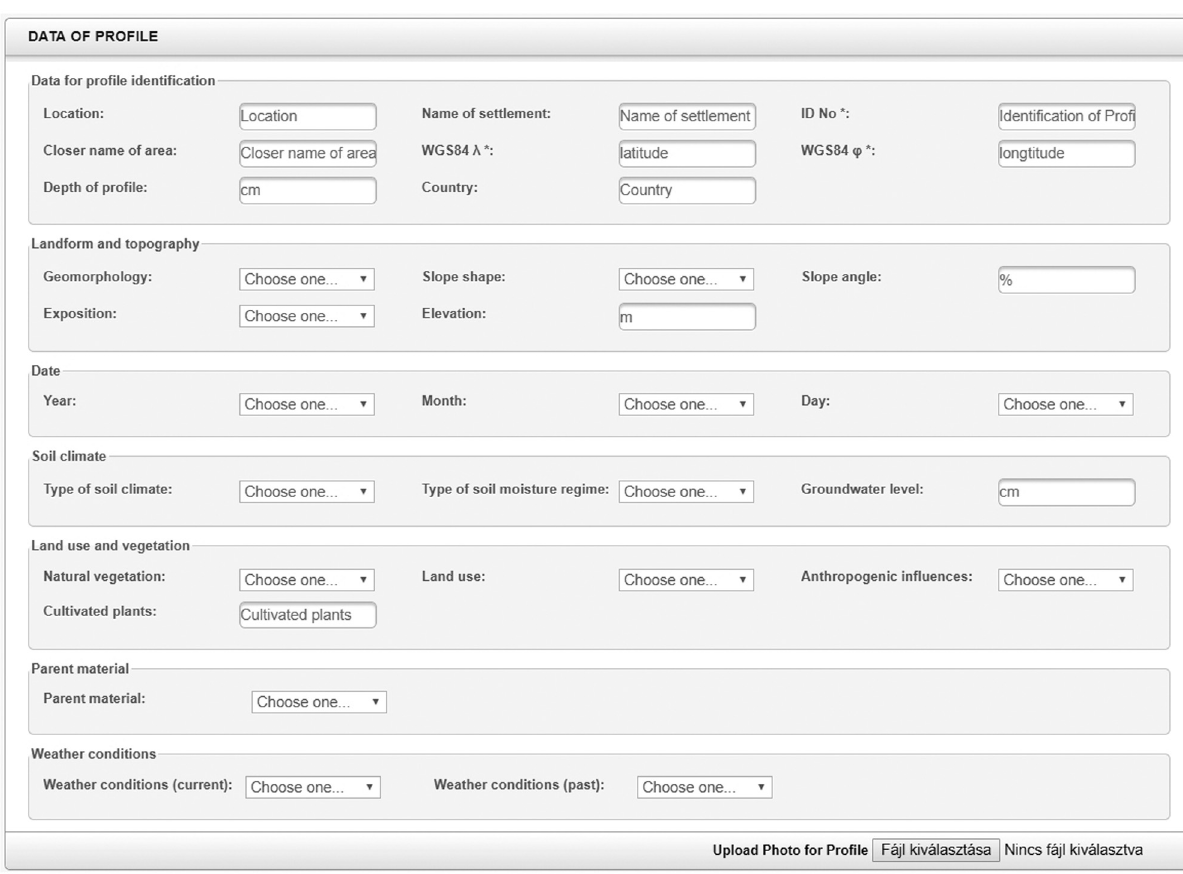
Figure 12: Initializations of soil description.